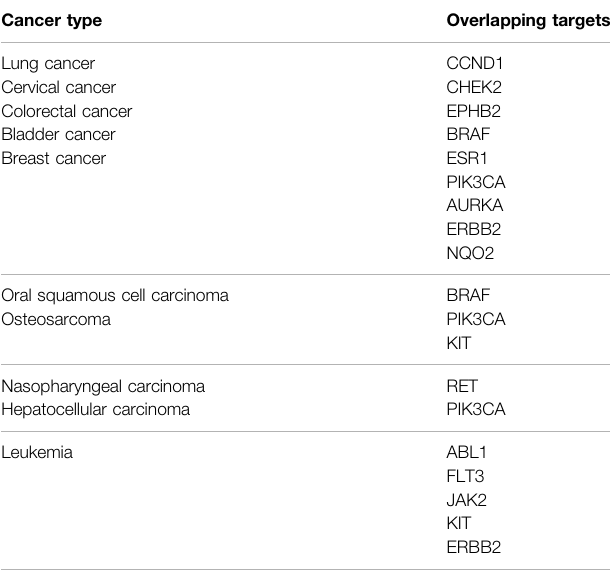
TABLE 1 | A list of overlapping targets of predicted erianin targets and cancer- speci fi c therapeutic targets obtained from Venn